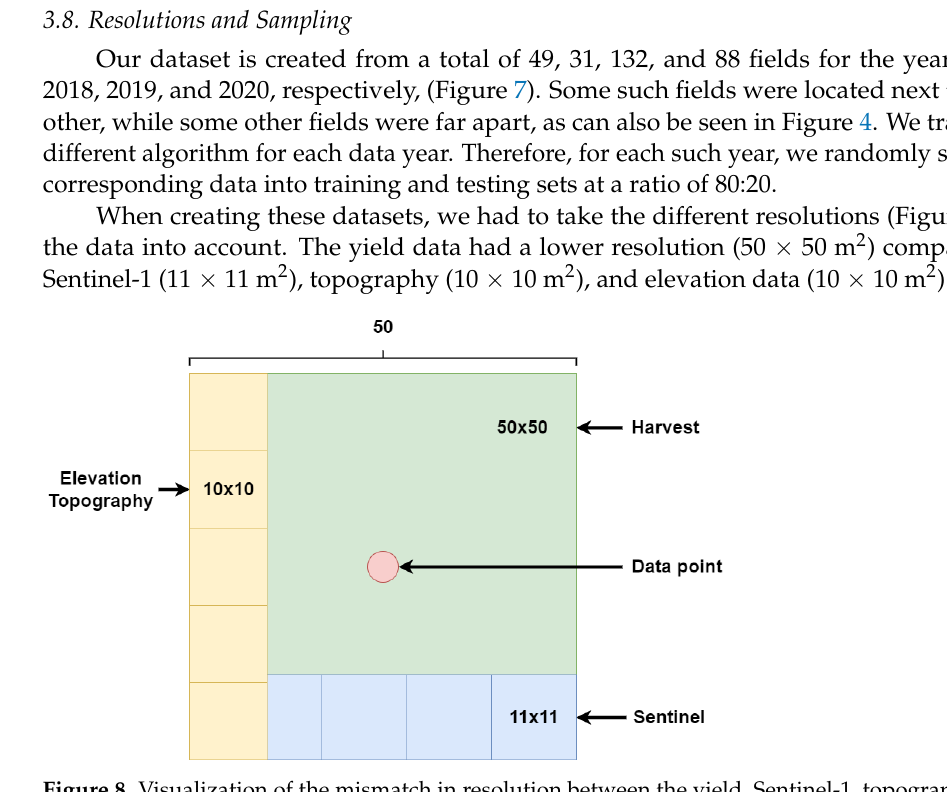
Figure 8. Visualization of the mismatch in resolution between the yield, Sentinel-1, topography, and elevation data. The lowest resolution was given by the yield data, where each data point summarizes yield within a 50 × 50 m 2 area. The satellite data had a finer resolution of 11 × 11 m 2 , while the topography and elevation data shared a resolution of 10 × 10 m 2 . This resolution difference was the reason for introducing grid sampling instead of just sampling the nearest data point in